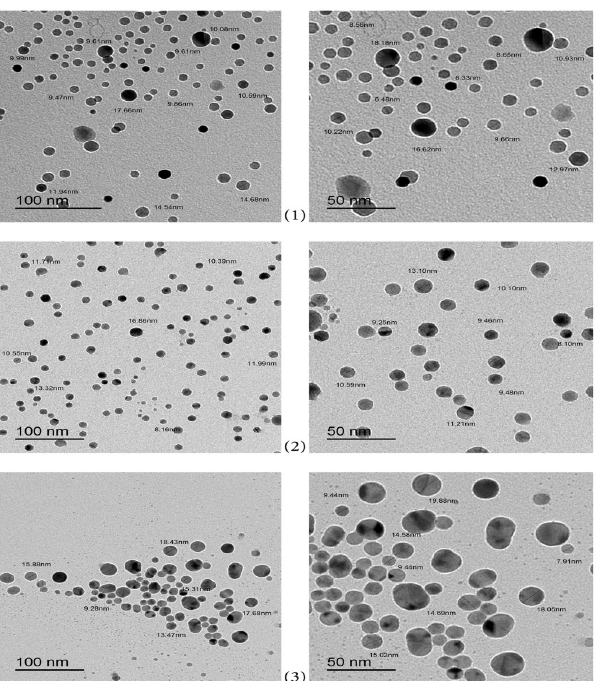
Fig 5. Transmission electron microscopy images of biosynthesized AgNPs at different magnifications of (1) Aurasperone A; (2) Fonsecinone A; (3) Aspernigrin A.